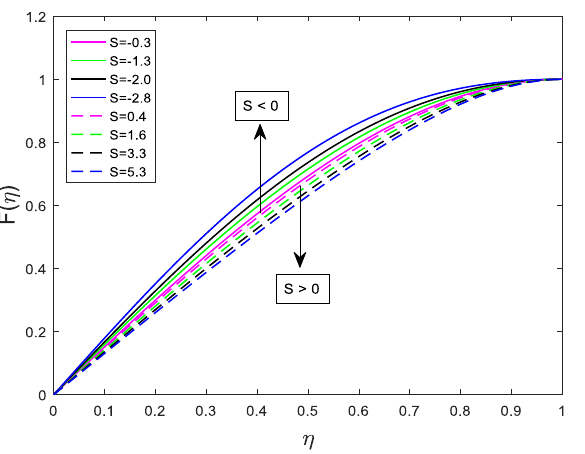
Figure 4: Effect of S on θ ( η ) for fixed β = 2.2, Ha = Ω T = N t = = 0.5 0.1, Ω = Ec = 0.5, Pr = Sc = 0.7, and Kr = N b C